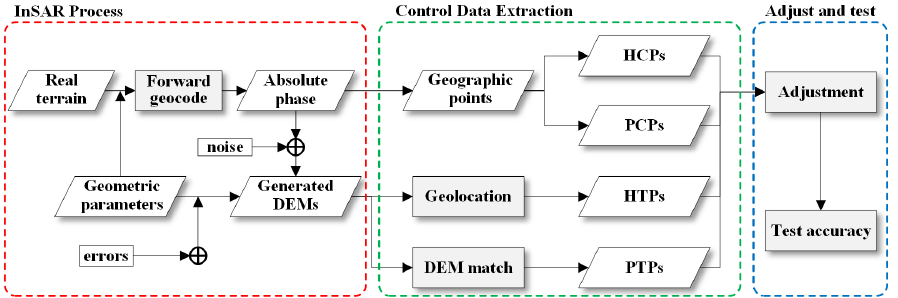
Figure 7. Flow chart of simulation experiment. The simulated data experiment includes three steps: InSAR processing, control data extraction, and